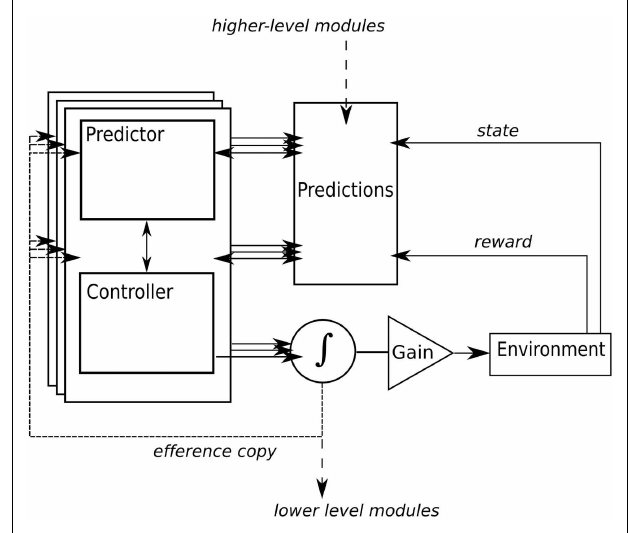
FIGURE 2 |A simplified internal models framework based on Glenberg and Gallese’s (2012)ABL model. Here, we add a signal for learning to predict the reward of actions. Multiple modules, composed of paired predictors and controllers, anticipate the sensory and affective consequences of actions. Prediction error, derived from the actual sensory and affective consequences, drives learning in the controller and adjusts the responsibility for a particular module. As in Glenberg and Gallese’s model, actual motor output is a weighted function of modules, higher-level modules provide hierarchical control of goal-based actions in the form of prior probabilities that influence lower-level module selection, and a gain controller is added for simulation in language